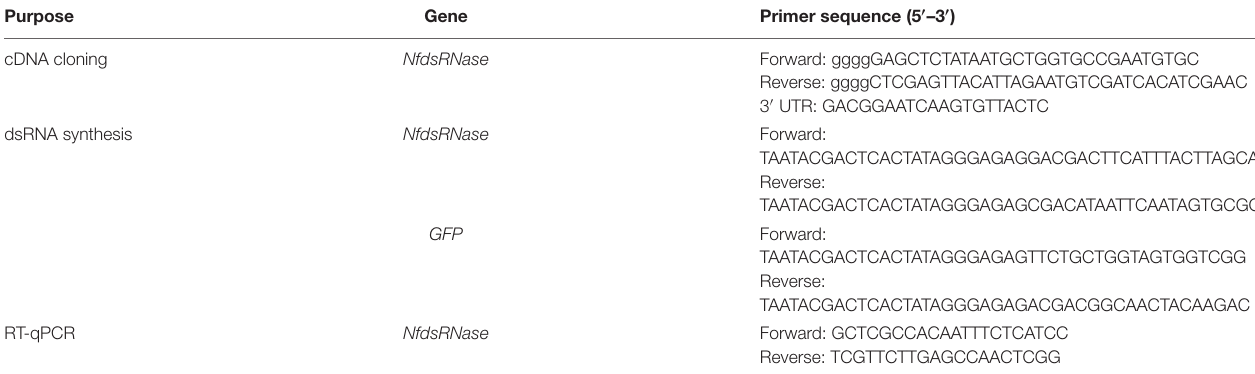
TABLE 1 | Primers used in this study.